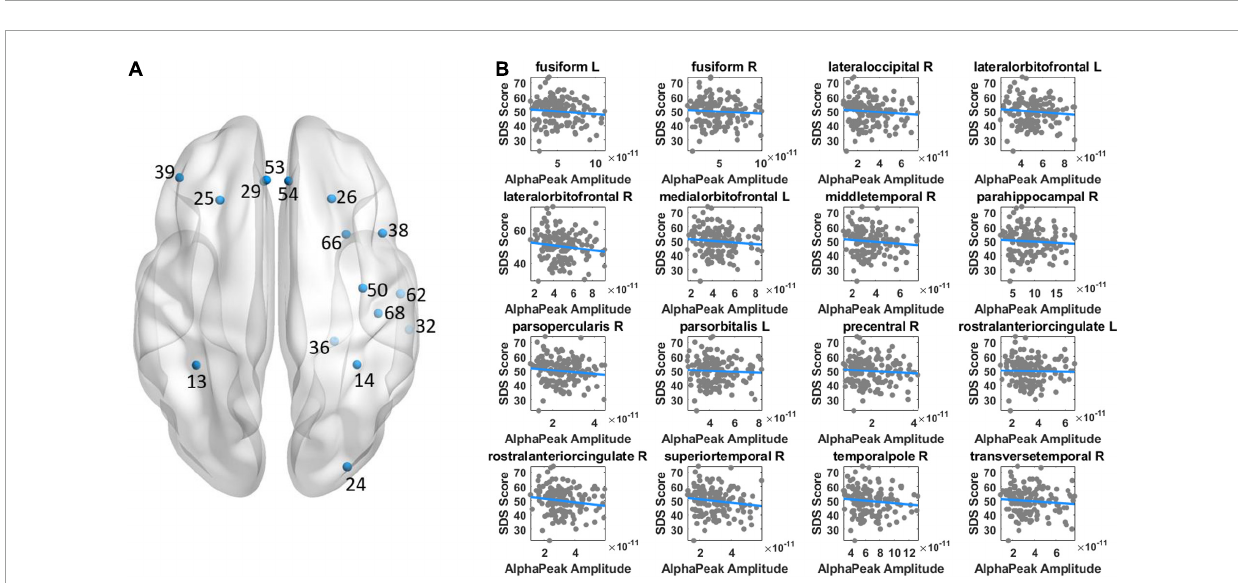
FIGURE3 Illustration of correlation results between alpha peak amplitude and depressive score. (A) The source regions that showed significant correlations are indicated by colored points. Positive or negative correlations are indicated by the red or blue color, respectively. (B) Shown are the scatter plots of significant correlations at individual regions. The color of the fitted line indicates positive (red) or negative (blue) correlation. The results revealed a negative correlation between alpha peak amplitude and depressive score. Other conventions are as in Figure 2 .